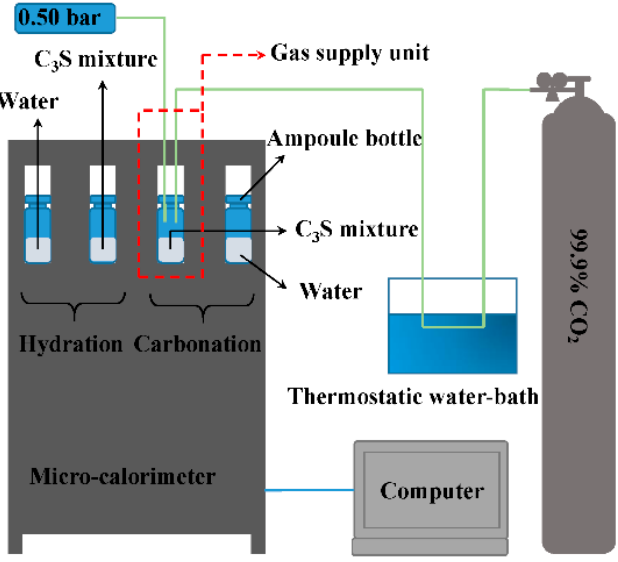
Figure 2. Schematic diagram of carbonation and hydration reaction heat experimental setup.